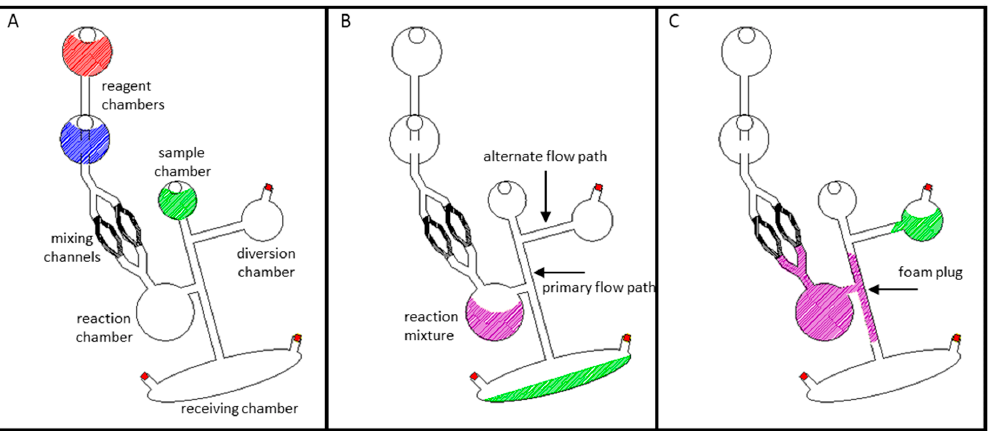
Figure 2. Blocking a channel with expanding polyurethane foam. ( A ) Schematic of the microchip prior to testing. The two reagents are separated, with architecture to mix them before sample is diverted. ( B ) Prior to channel blockage, dye solution freely flows through the open channel architecture. ( C ) Upon foam expansion and curing, the primary channel (2 mm diameter) is blocked. When new sample is added and the microdevice spun, fluid is diverted into the previously unfavorable flow